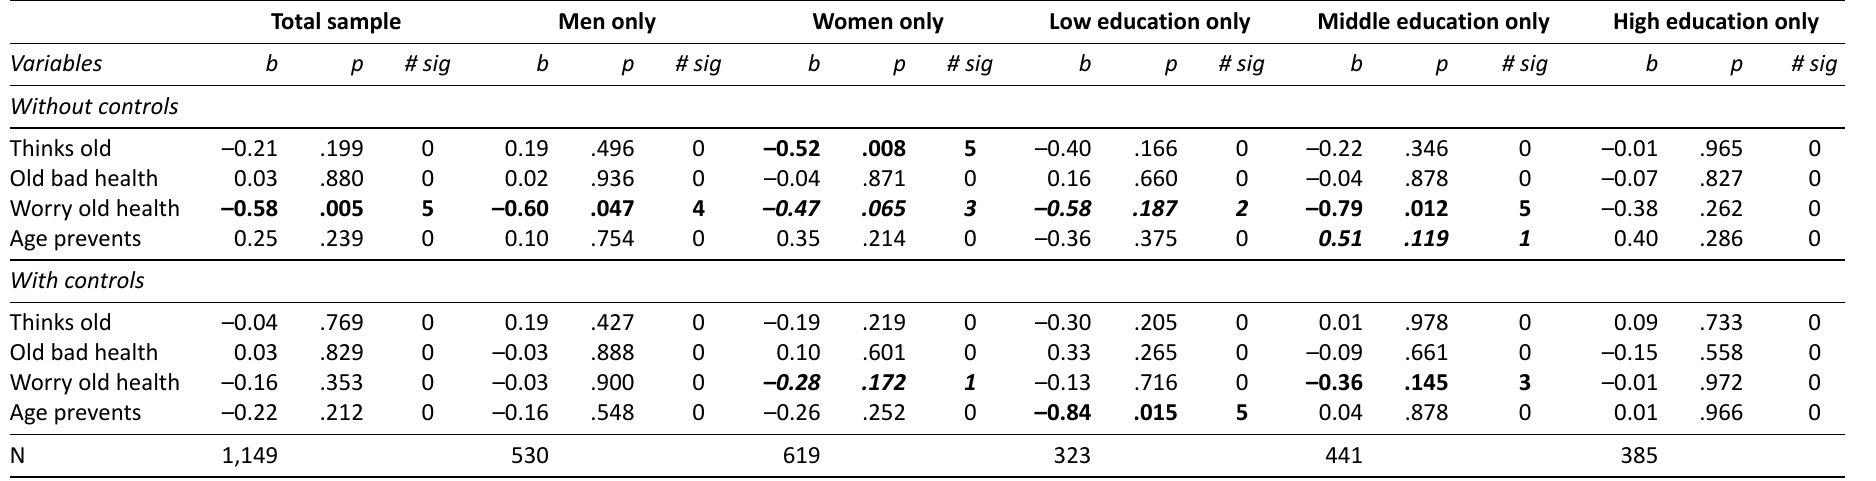
Table A5. Preferred retirement age wave 8 (multiple